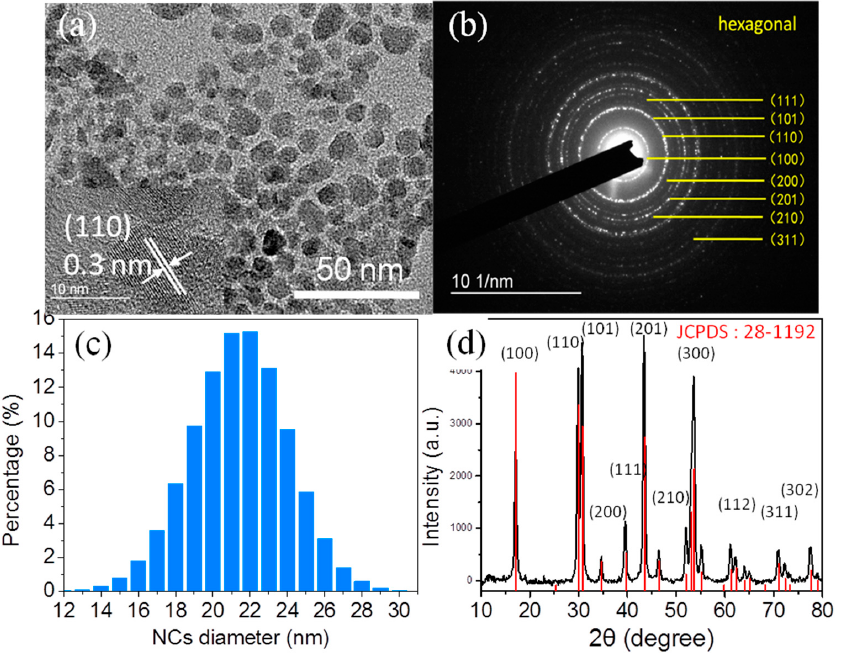
Figure 2. ( a ) TEM image and HR-TEM image (inset); ( b ) SAED pattern; ( c ) size distribution; and ( d ) XRD pattern of the NaYF 4 :Yb,Er NCs. pattern of the NaYF 4 :Yb,Er